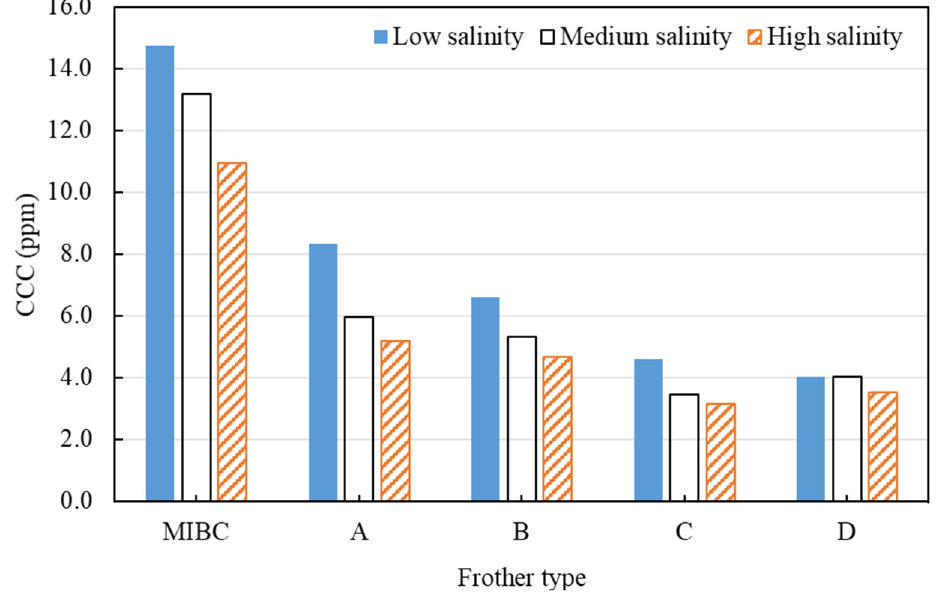
Figure 12. CCC comparison of five frothers at three water salinities.